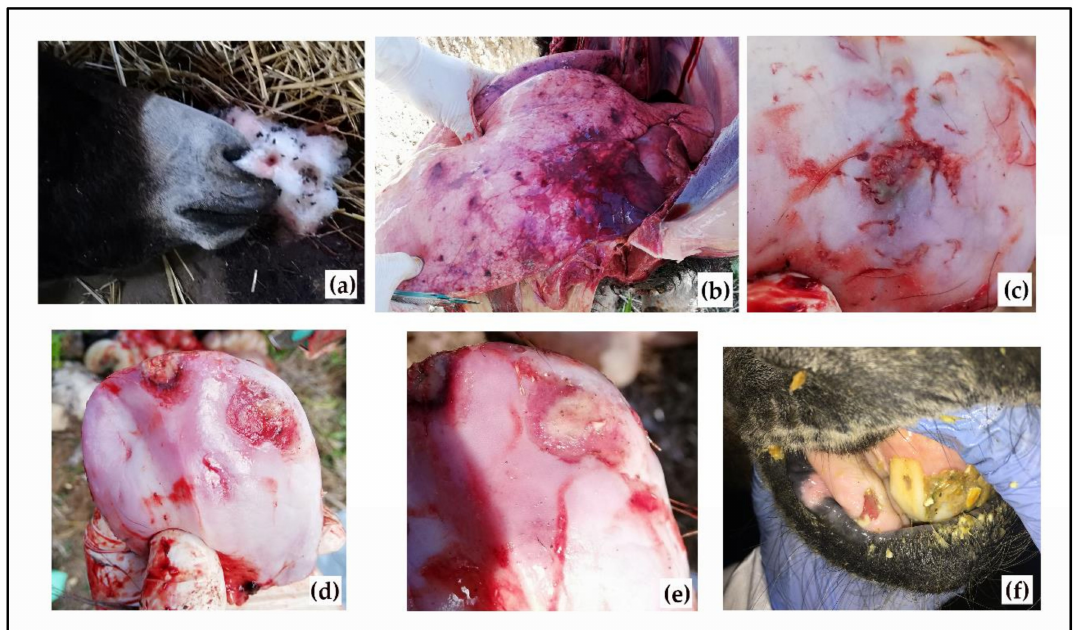
Figure 1. Gross lesions: leakage of foamy fluids from the nostrils ( a ), acute oedema with areas of reddening and petechiae in the lungs ( b ), and ulcerative lesions on the tongue of dead foal ( c – e ) and on a live animal ( f